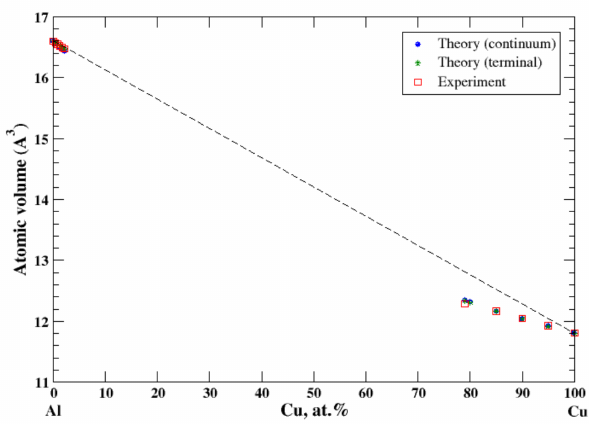
Figure 2. Atomic volume vs. concentration for Al-Cu alloy system. The experimental data are from Ref. [16] (p. 328 and p.